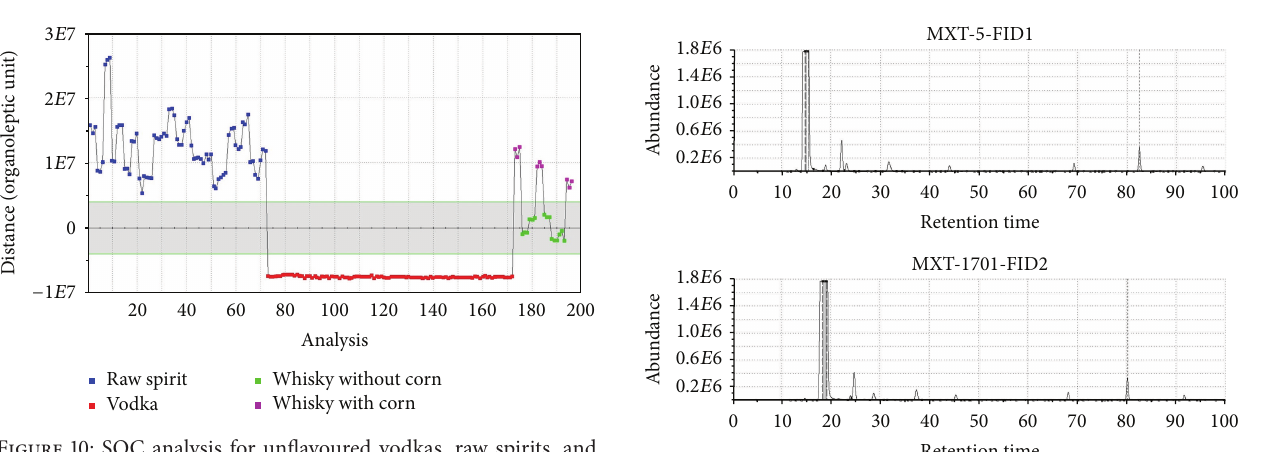
Figure 10: SQC analysis for unflavoured vodkas, raw spirits, and whiskies: whisky without corn, reference group.